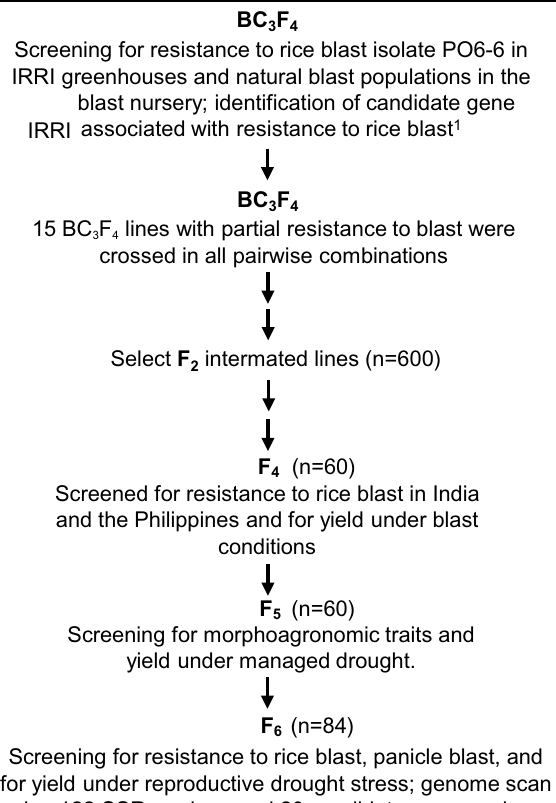
Figure 1. Breeding scheme describing the development of intermated lines from BC 3 F 4 Vandana/Moroberekan families generated by Wu et al. 13